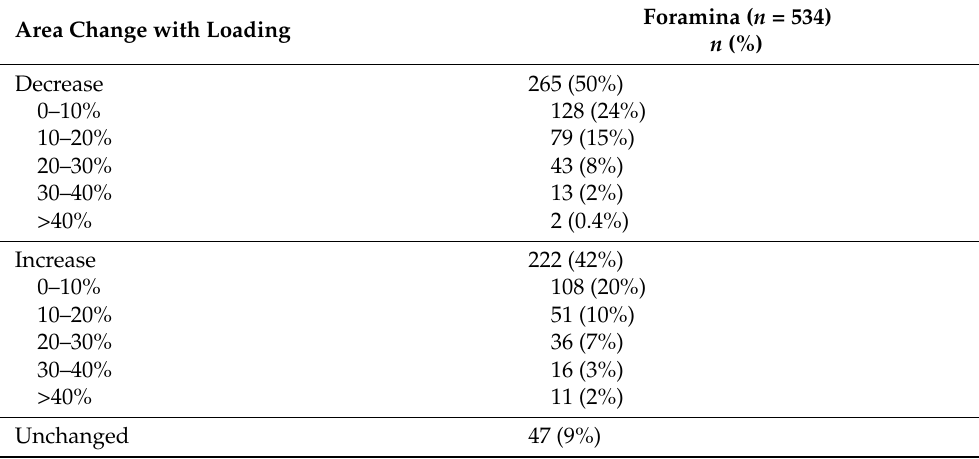
Table 1. Distribution of foraminal area change at MRI during loading compared to unloaded.